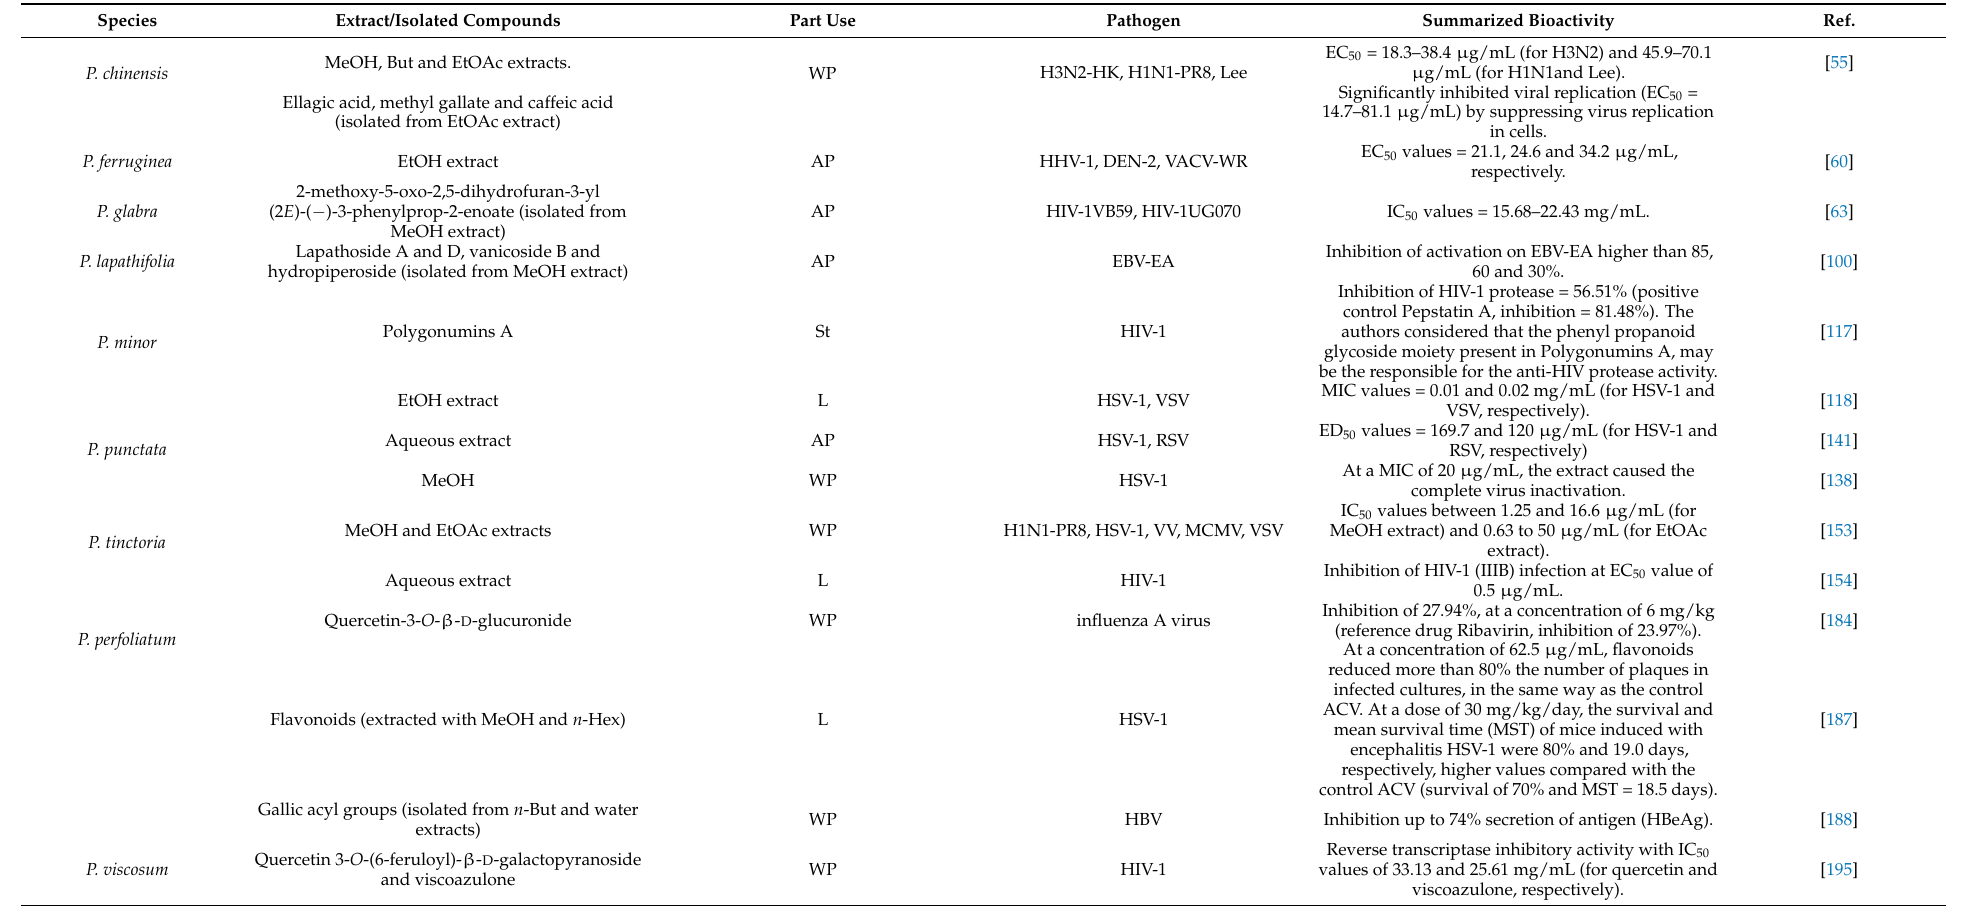
Table 6. Antiviral activities of Persicaria and Polygonum species. Extracts, compounds, part of the plant used, target virus and references are shown. Extracts: EtOH (ethanol); MeOH (methanol); Hex (hexane); EtOAc (ethyl acetate); But (butanol). Part used: L (leaves); F (flowers); Fr (fruits); R (roots); Sp (sprouts); S (seeds); St (stems); Rz (rhizomes); T (tubers); B (barks); WP (whole plant); AP (aerial